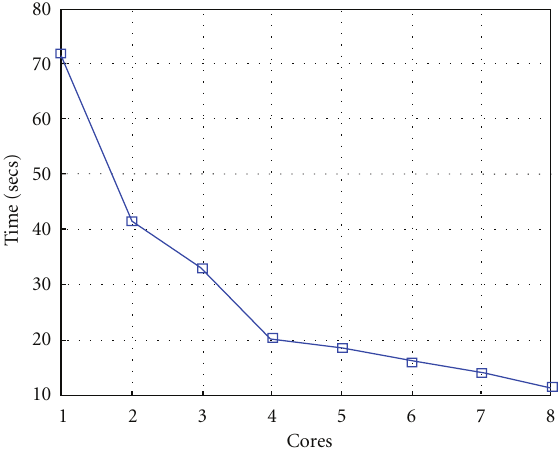
Figure 21: Test 2: Algorithm SI: Total execution time versus the number of cores. Δ τ I = 0 .